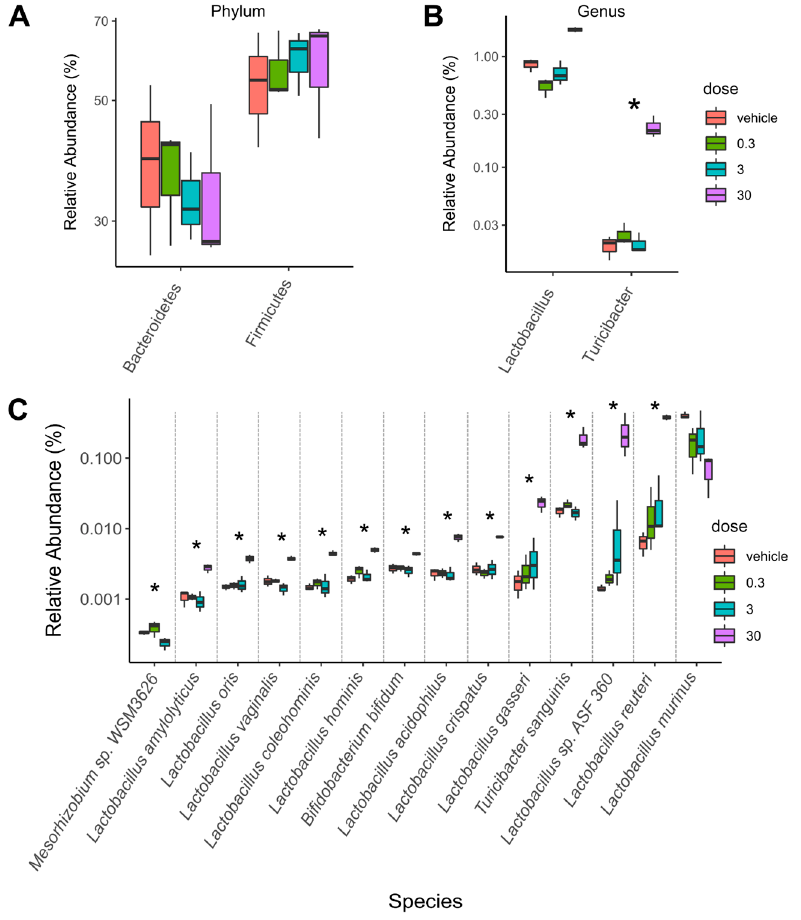
Figure 1. TCDD enriched Lactobacillus species in the cecum microbiota. Taxa abundance were assessed in metagenomic cecum samples from male C57BL/6 mice following oral gavage with sesame oil vehicle or 0.3, 3, or 30 µg/kg TCDD every 4 days for 28 days ( n = 3). Significant shifts in relative abundances of taxa are presented at the ( A ) phylum, ( B ) genus, ( C ) and species levels. Significance is denoted with an asterisk (*; adjusted p -value < 0.1).